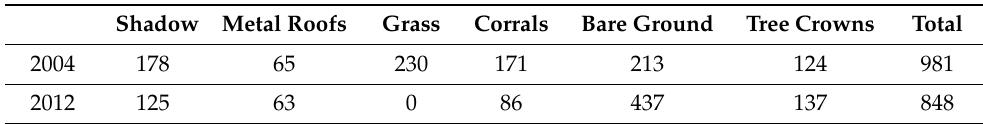
Table 2. The number of training sample points selected for each of the six targeted classes during pixel-based random forest classification.